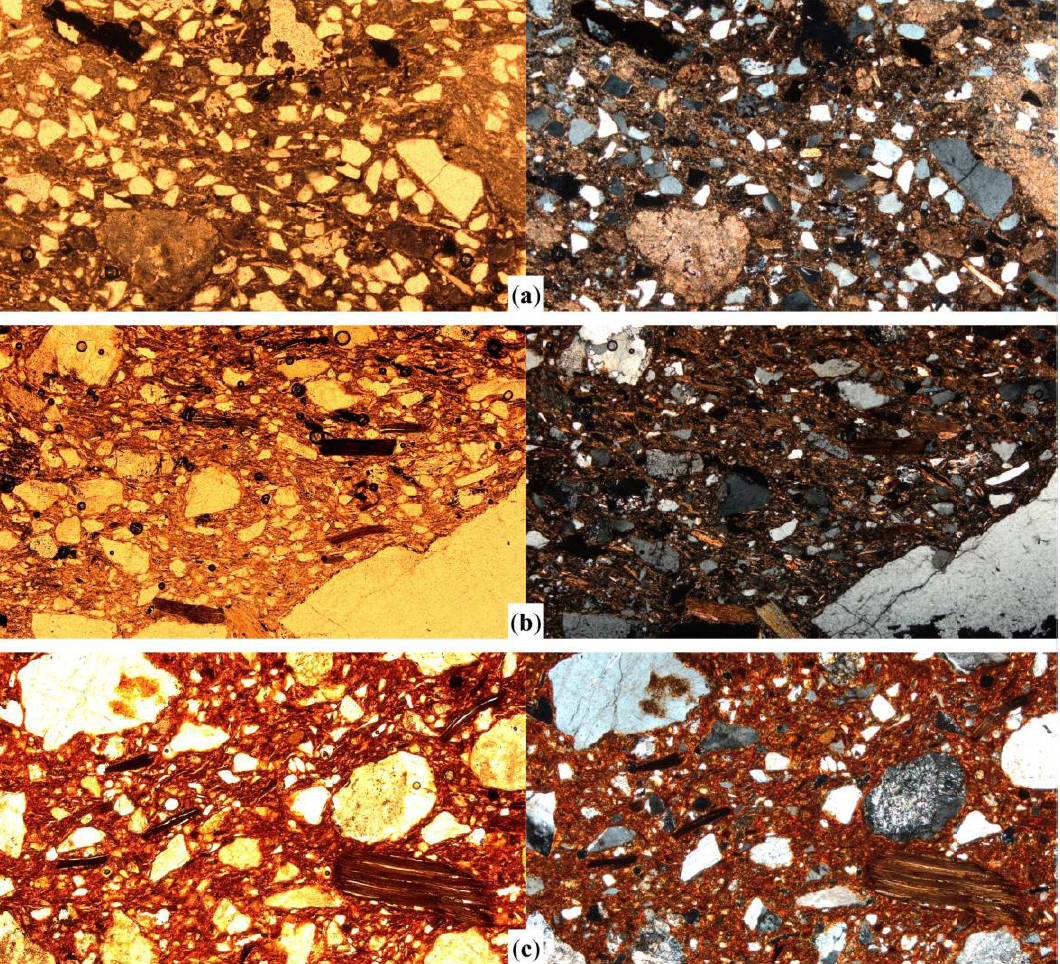
Figure 4. Photomicrographs of the selected samples with an estimated range of firing temperatures below 900 °C showing the main features of biotite inclusions. Sample SMVa06, with limestone inclusions, fired below 750 °C ( a ); sample SPM05 with moderate to highly pleochroic biotite fired at 800–850 °C ( b ); and sample SAO04, fired at about 900 °C with slightly open cleavage in biotite inclusions ( c ). All the images were captured in plane polarized light (left column) and crossed polars (right column), at 40× magnification. Image width = 3 mm.